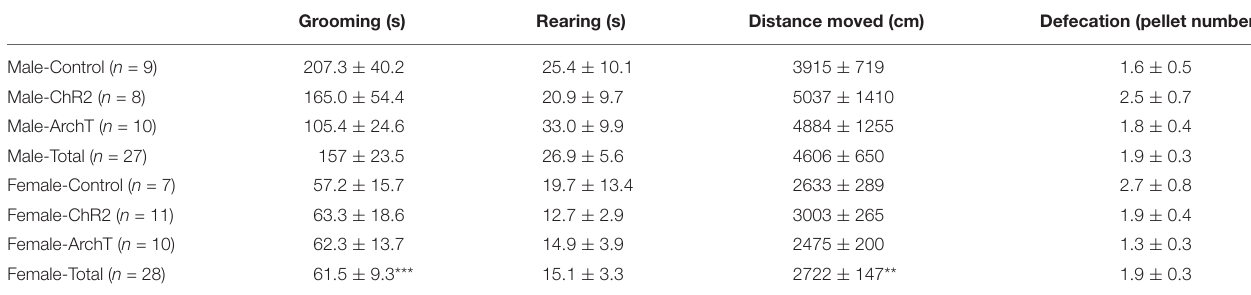
Grooming (s) Rearing (s) Distance moved (cm) Defecation (pellet